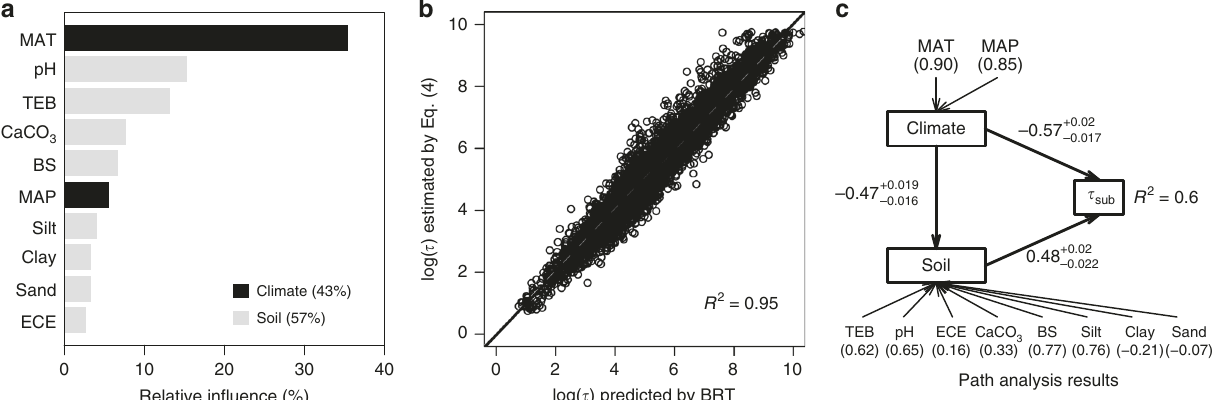
Fig. 6 Controls over soil organic carbon turnover times at the global scale. a The relative in fl uence (%) of predictors for the boosted regression tree (BRT) of turnover times. MAT mean annual temperature, MAP mean annual precipitation, pH soil pH, TEB the total exchangeable bases (i.e., the sum of exchangeable cations in the soil), ECE the electrical conductivity of the soil, BS base saturation, CaCO 3 calcium carbonate. b The performance of the BRT in predicting estimated τ . The grey dashed line shows the 1:1 line. c Path analysis results on the direction and magnitude of the effects of latent variable climate (using MAT and MAP as indicators identi fi ed by the BRT) and soil (using pH, TEB, ECE, BS, CaCO 3 , clay, silt and sand content as indicators identi fi ed by the BRT) on turnover times. Numbers in the parentheses show the loading of the indicator to the latent variable, i.e., the correlation coef fi cents between the latent variables and the latent variables. See details in Methods section for the